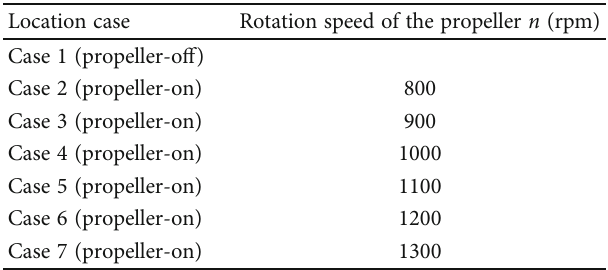
Figure 3: Comparisons between simulated results and experimental (EXP [20]). Table 2: The cases for the numerical